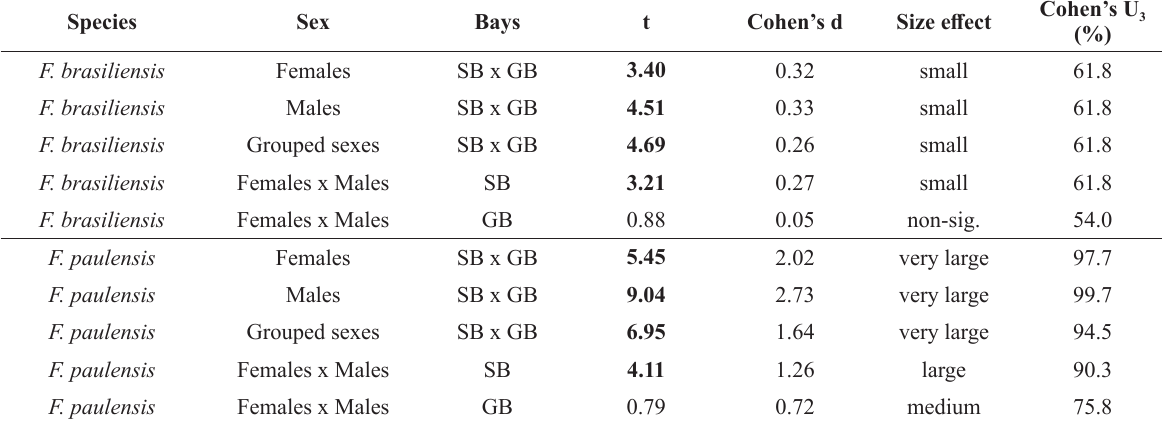
Comparisons of b values (W=a.TL b ) for each sex, species ( F. brasiliensis and F. paulensis ) and bay.